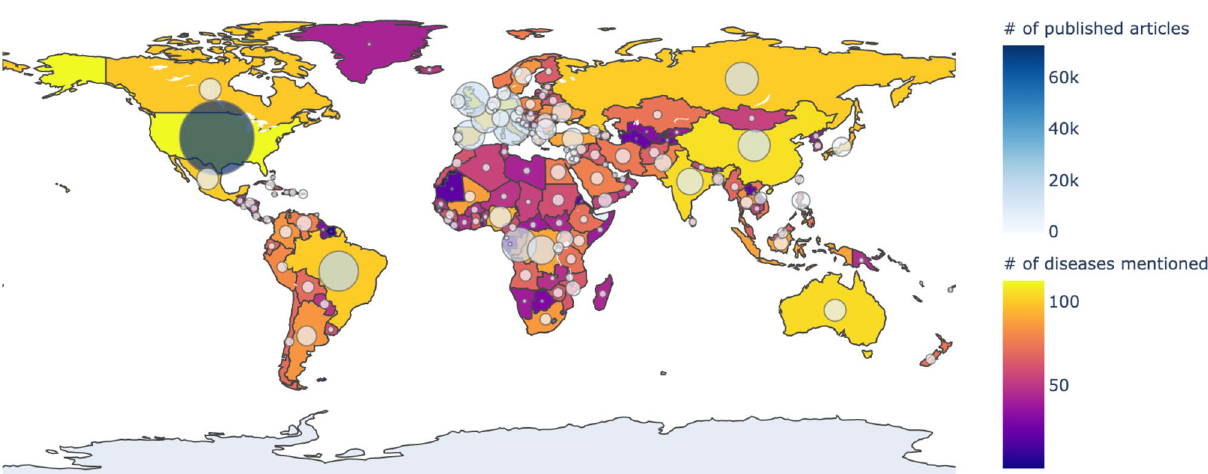
Figure 2. The number of articles published in each country collected from Medisys from January to December 2019: the closer the color of the country to yellow, the more diseases occurred, and the larger the circle, the more articles have occurred. The figure was created in Python3 using the Basemap